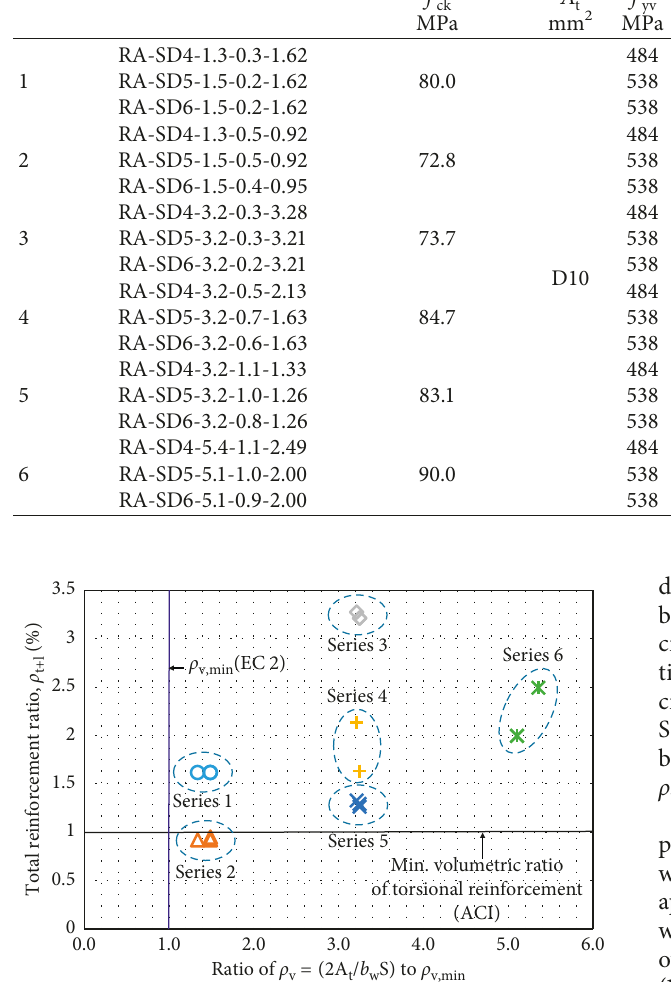
Figure 3: Reinforcement ratios of specimens and minimum re- inforcement requirement.